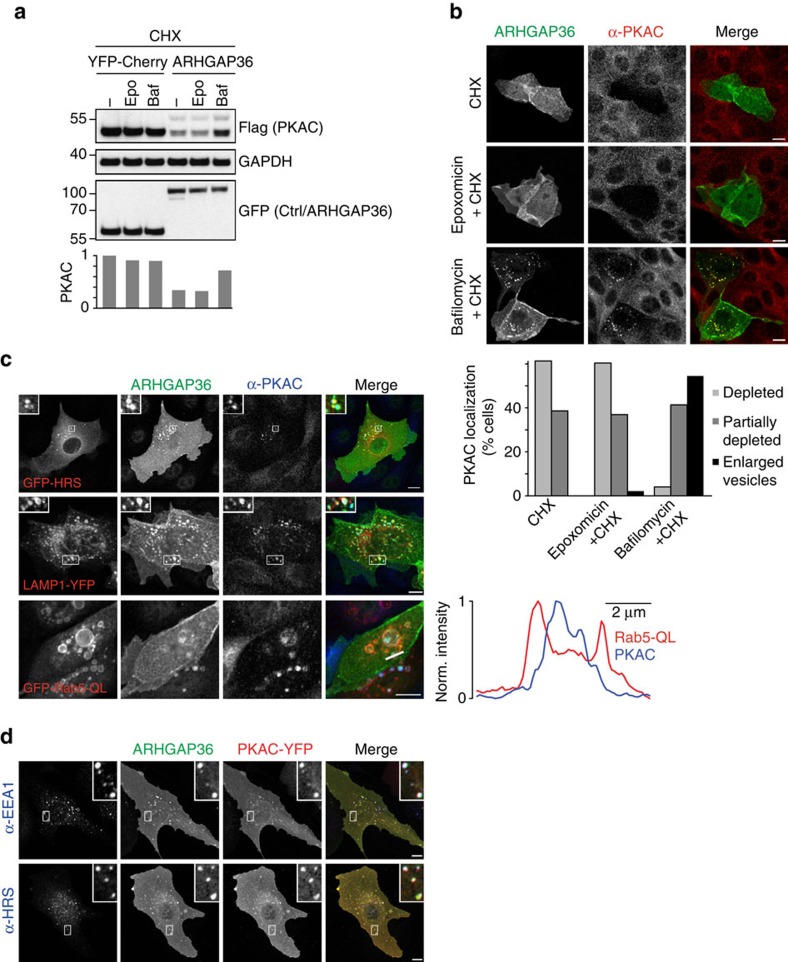
ARHGAP36 targets PKAC for lysosomal degradation.(a) HEK293T cells were transfected with PKAC-Flag and YFP-ARHGAP36 or YFP-Cherry control as indicated. Before collecting, cells were pretreated for 30 min with epoxomicin (50 nM) or bafilomycin (100 nM), before cycloheximide (CHX; 50 μg ml−1) addition for a further 6 h. Lysates were immunoblotted with the indicated antibodies. Flag-PKAC levels were densitometrically evaluated and normalized to the first lane shown. (b) MDCK cells were transfected with YFP-ARHGAP36 or YFP control for 8 h and, where indicated, were pretreated for 30 min with epoxomycin (100 nM) or bafilomycin (100 nM), before CHX (1 μg ml−1) addition for a further 8 h. Cells were then fixed after a total of 16 h transfection and subjected to immunofluorescence using antibodies against GFP and PKAC. Images were collected by confocal microscopy. Scale bars, 10 μm. Graph shows the percentage of YFP-ARHGAP36-transfected cells with the respective phenotype, 100 cells counted per condition. (c) Confocal micrographs of MDCK cells transfected with Flag-ARHGAP36 together with GFP-HRS, LAMP1-YFP or GFP-Rab5-QL. Cells were fixed and subjected to immunofluorescence using antibodies against GFP, Flag and PKAC. Scale bars, 10 μm. For Rab5-QL, line scan fluorescence intensity profiles are shown on the right. In red: Rab5-QL, in blue: PKAC. (d) Confocal micrographs of U2OS cells transfected with PKAC-YFP and Flag-ARHGAP36. Cells were fixed and subjected to immunofluorescence using antibodies against GFP, Flag, EEA1 and HRS. Scale bars, 10 μm.